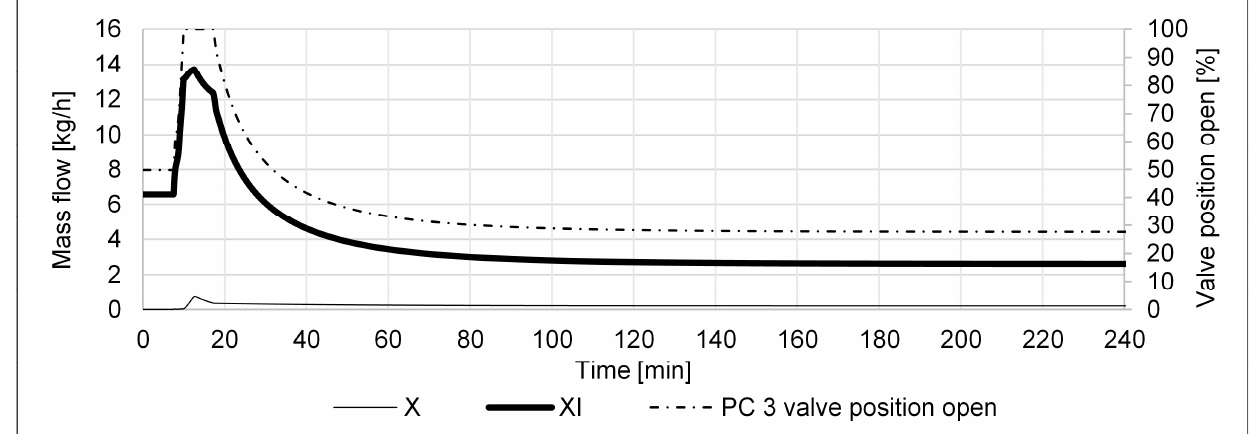
Figure 26 . Purge X and recycle XI mass fl ows and position of the recycle valve (left and right vertical Figure 26. Purge X and recycle XI mass flows and position of the recycle valve (left and right vertical axis) of scenario (i). axis) of scenario